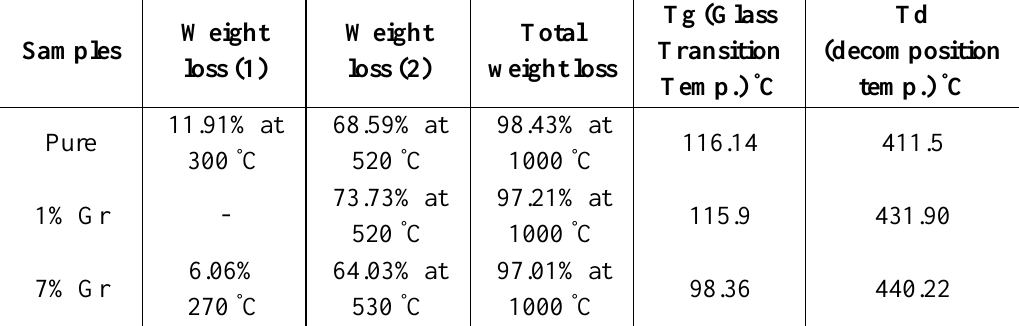
Table 3: Weight loss, Tg, and Td for blend and nanocomposites.